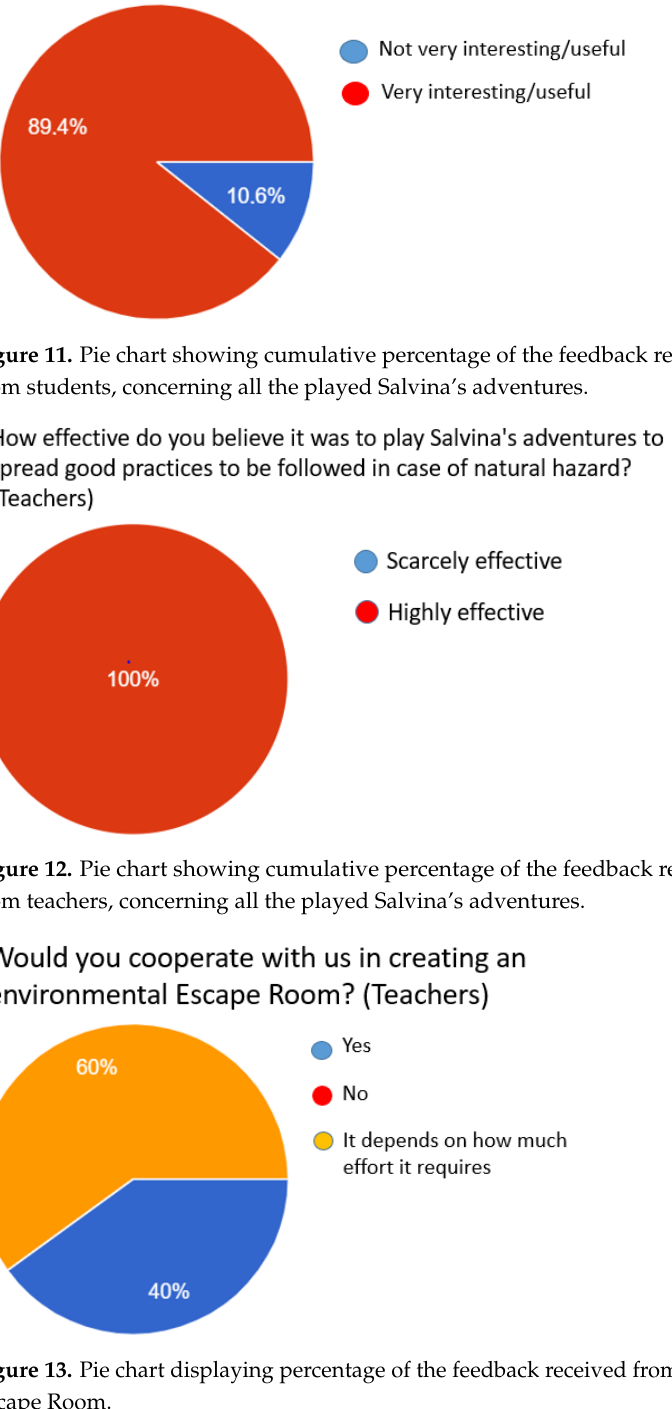
Figure 13. Pie chart displaying percentage of the feedback received from teachers about the Salvina’s Escape Escape Room.